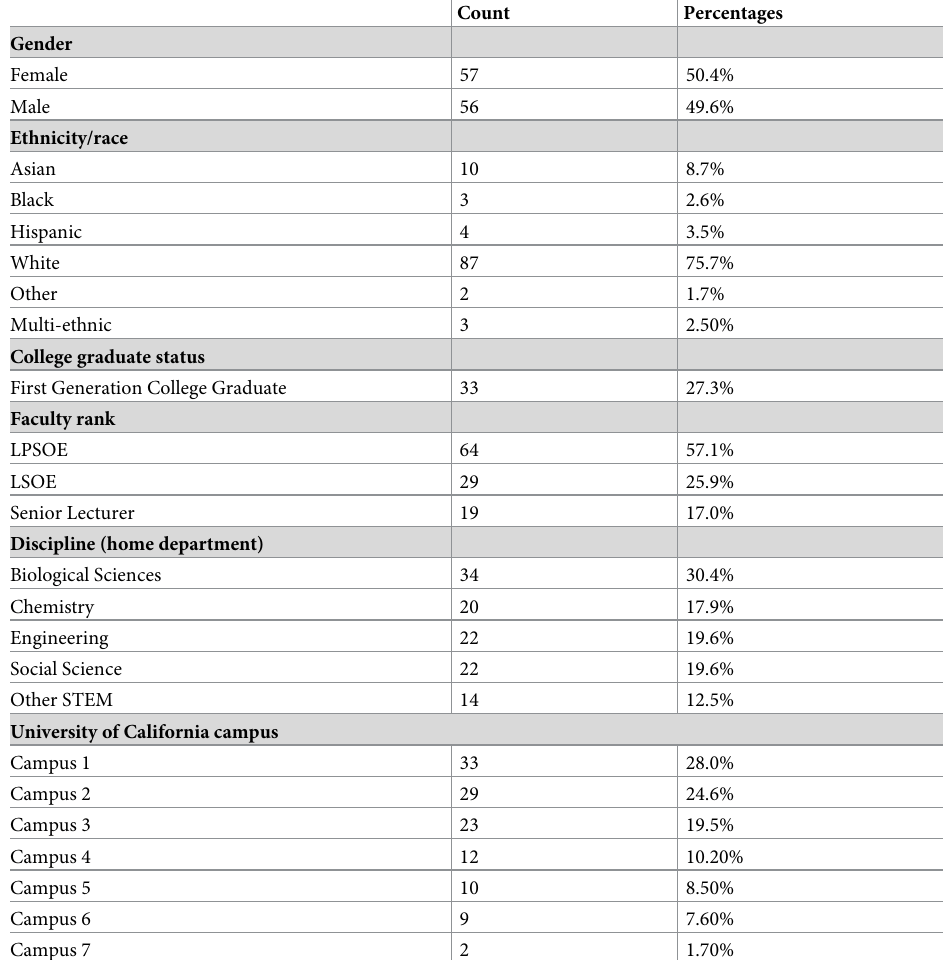
Table 1. Demographic L(P)SOE faculty